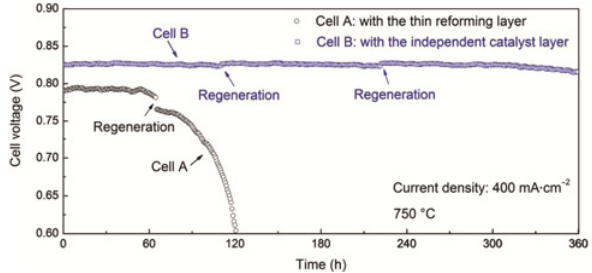
Ce 0.9 Ca 0.1 O 2 − δ catalyst layer sintered on anode (Cell A) and independent catalyst layer (Cell